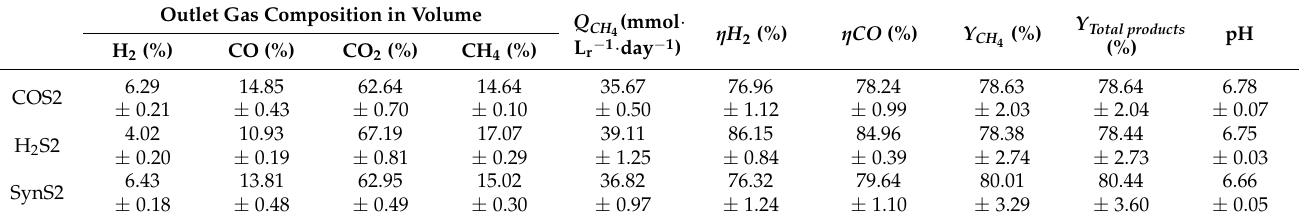
Table 4. Comparison of 3 start-up strategies for syngas biomethanation in the continuous BCR-C. (S2: Stage 2 with normal reactor operation. COS2: the test run was started up by feeding with 50% CO + 50% N 2 ; H 2 S2: by feeding with 50% H 2 + 12.5% CO 2 + 37.5% N 2 ; and SynS2: by feeding with 20% H 2 + 50% CO + 30% CO 2